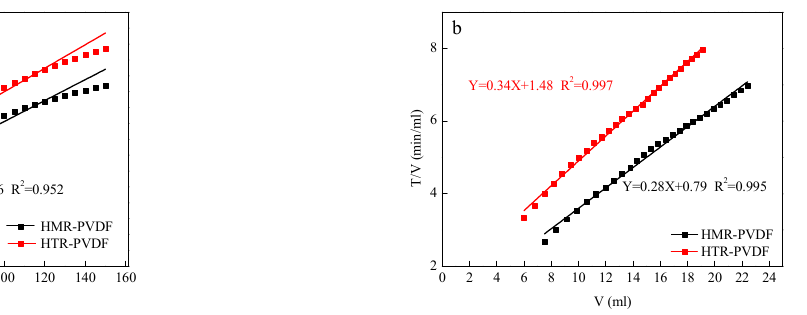
Figure 1. Determination of fouling mechanisms from model fitting to experimental data (dotted line indicates the fitted straight line). ( a ) Fitting of pore blocking model, ( b ) Fitting of cake layer